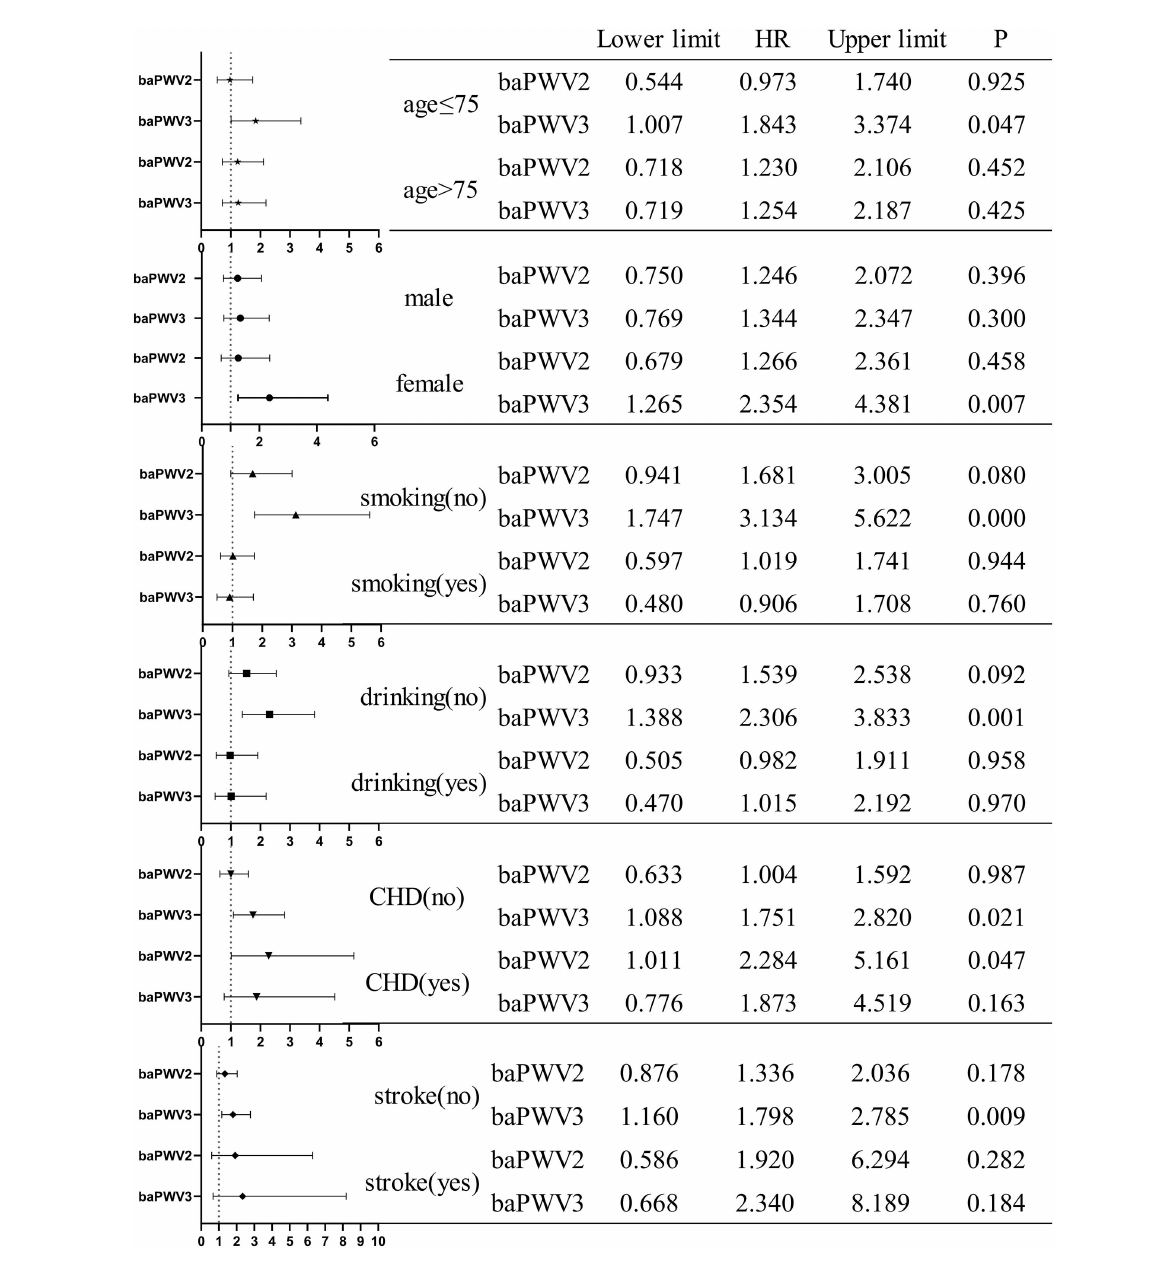
all-cause mortality in the general population with a